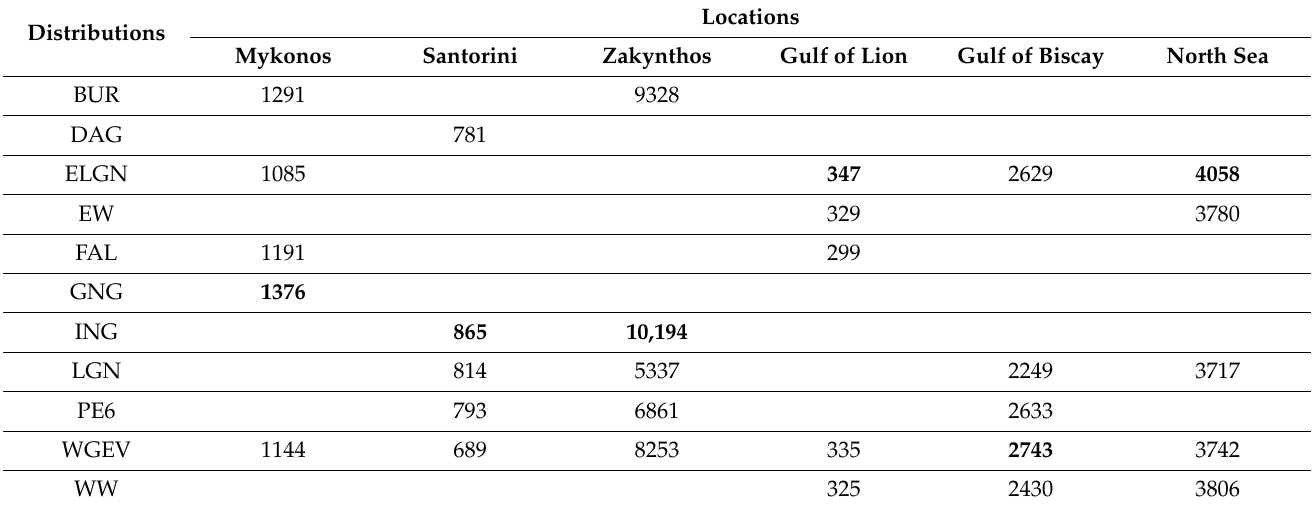
(cid:0) × (cid:1) Table 7. Values of the GC 10 6 goodness-of-fit criterion for the Johnson–Wehrly bivariate distribution for the examined locations along with the best fit distributions for wave energy flux. Boldface digits indicate the optimum value of GC . Distributions